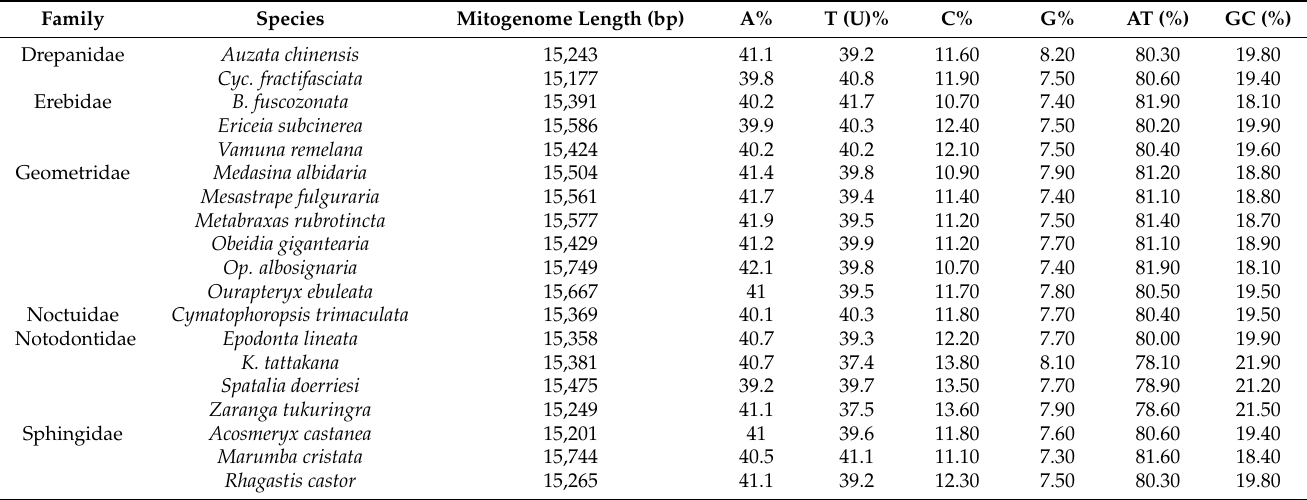
Table 1. Nucleotide composition of the 19 mitochondrial genomes of